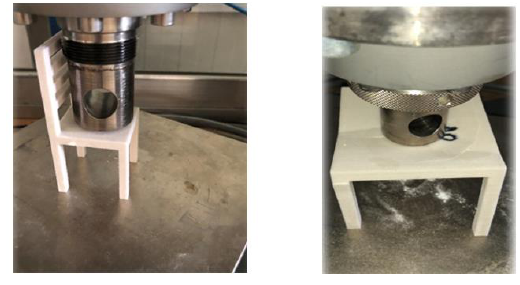
Figure 7. Specimens Compression